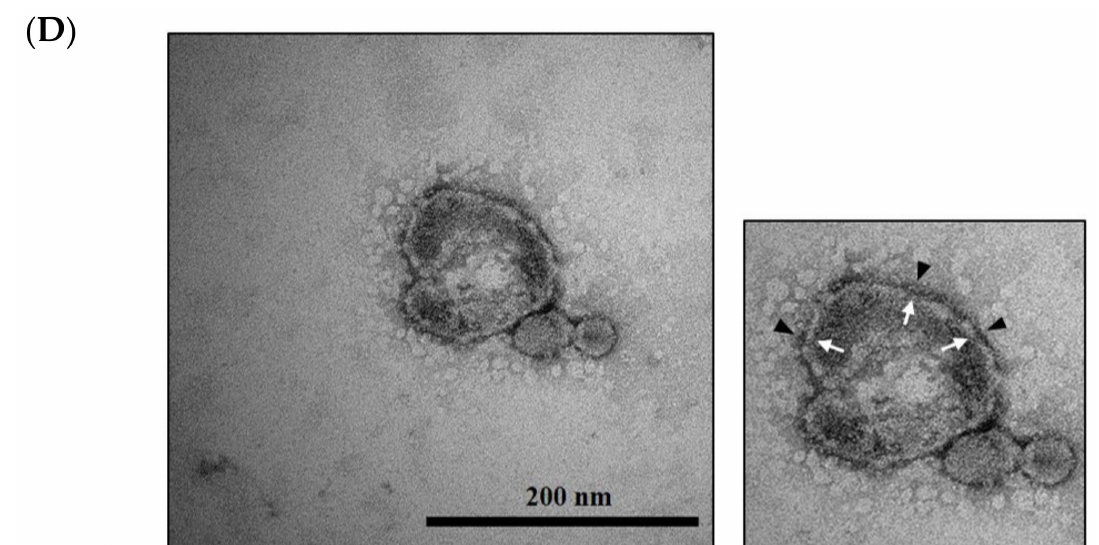
Figure 2. Purification and characteristics of probiotic bacteria-derived extracellular vesicles (PB- EVs). ( A ) A representative frame from one of the PB-EV nanoparticle tracking analysis videos is shown. The purified EVs were diluted to 1:1000 in DPBS. ( B ) Particle size and number of PB-EVs determined by nanoparticle tracking analysis (NTA). ( C ) Protein and particle concentration of PB- EVs. ( D ) Cryo-TEM image analysis with the negative staining of Leuconostoc holzapfelii -derived extracellular vesicles (hs- Lh EVs). The outlined EV images are enlarged, and the lipid bilayer is indicated by black and white arrows, which refer to the potential double membrane of the vesicles. Scale bars, 200 nm. Bl EVs, Bifidobacterium longum -derived extracellular vesicles; Ba EVs, Bifidobacterium animalis -derived extracellular vesicles; La EVs, Lactobacillus acidophilus -derived extracellular vesicles; hs- Lh EVs, extracellular vesicles derived from Leuconostoc holzapfelii isolated from the human scalp; Lp EVs, Lactobacillus plantarum -derived extracellular vesicles. All data are reported as the mean ± SD of three independent